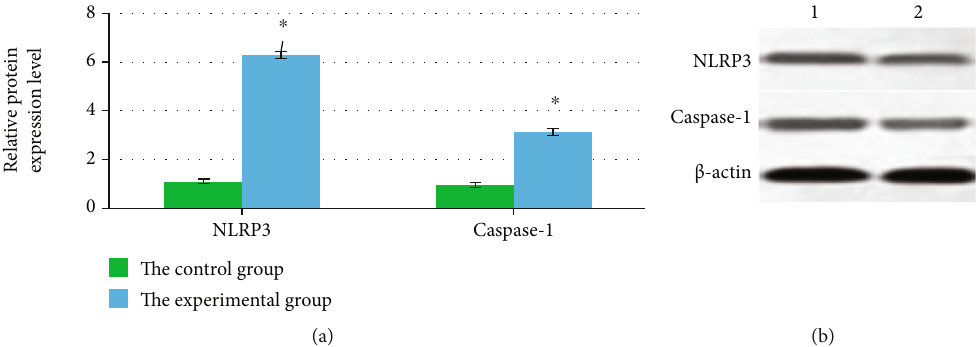
Figure 4: Levels of NLRP3 and caspase-1 proteins in subcutaneous tissues. (a) The protein expression level of NLRP3 and caspase-1. (b) The protein band of NLRP3 and caspase-1; 1 and 2 referred to the experimental group and the control group, respectively. ∗ indicated that the comparison with the control group showed P < 0 : 05